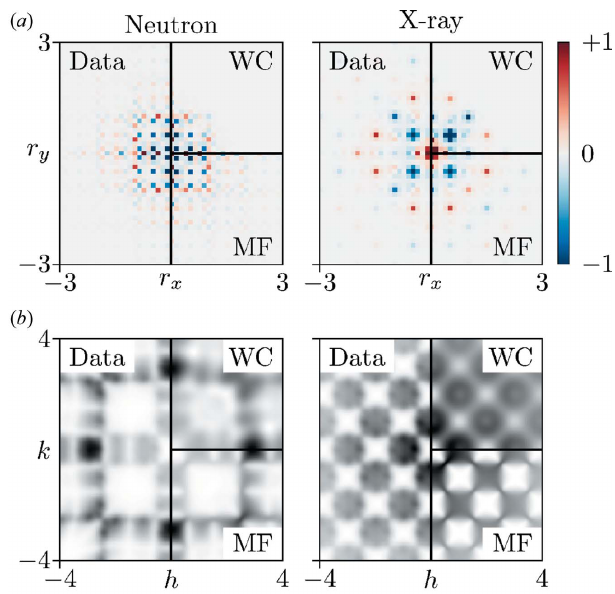
Figure 5 ( a ) A comparison of the 2D- (cid:2) PDFs calculated from the diffuse scattering of the model data (left of panel), the WC refinement (top right of panel) and MF refinement (bottom right of panel). Positive correlations are indicated in red and negative correlations in blue. ( b ) A comparison of the diffuse scattering used to calculate the 2D- (cid:2) PDFs in panel ( a